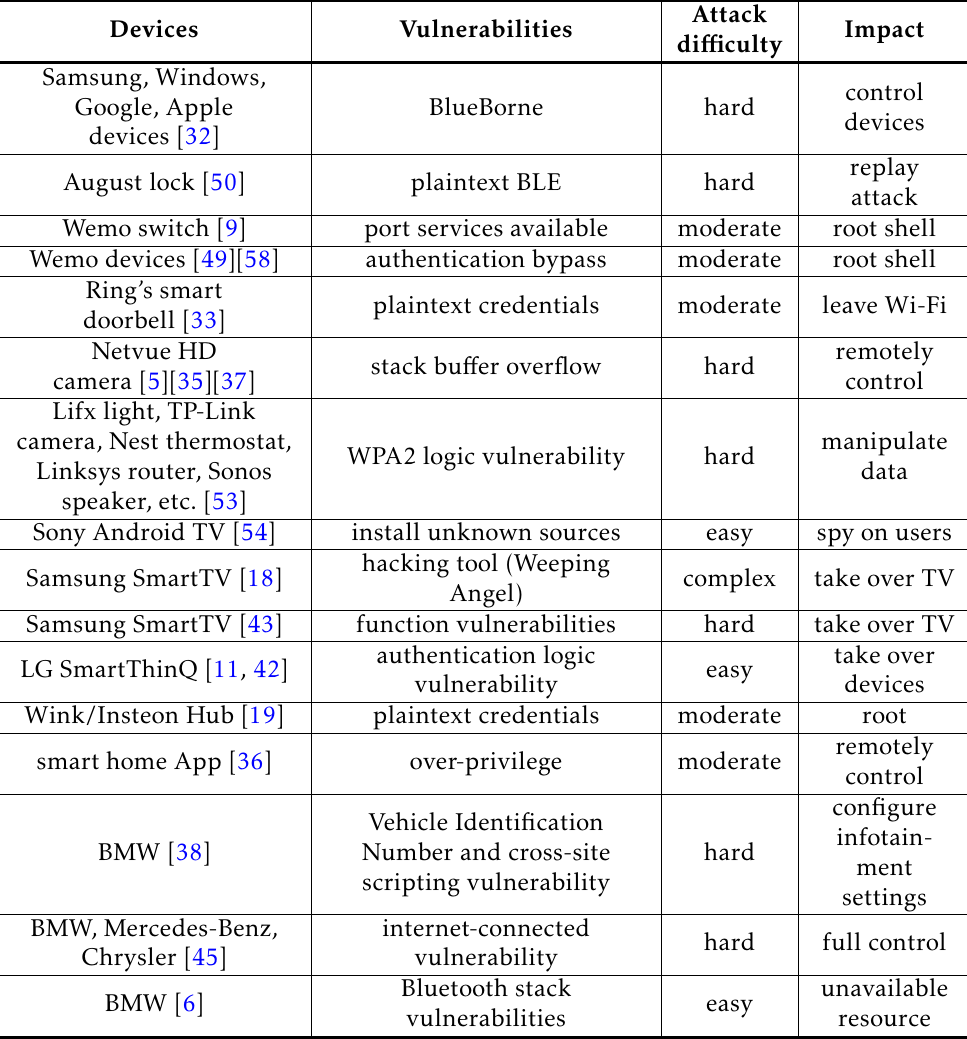
Table 1. Vulnerabilities of IoT